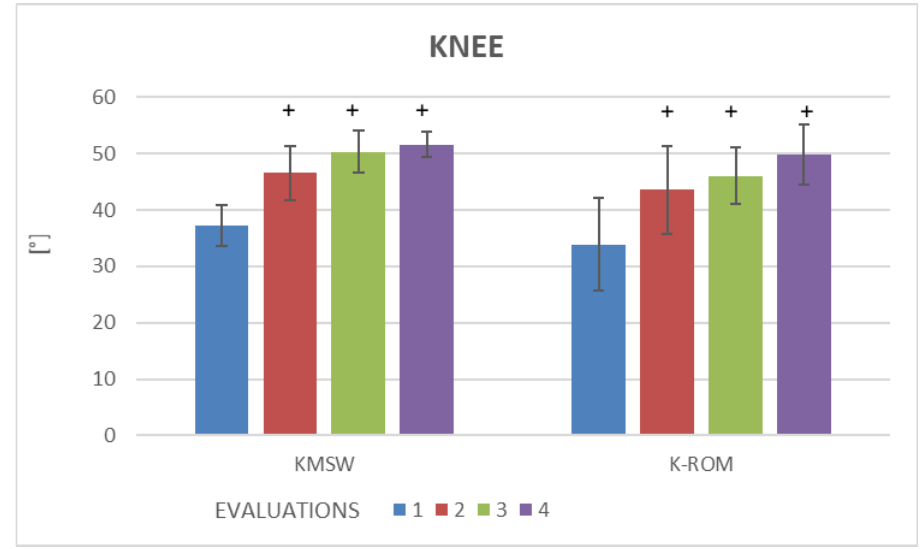
Figure 3. Outcomes of kinematics gait variables, for knee joint of the paretic side, expressed as median values and the interquartile range. + Statistically significant difference in comparison to baseline ( p < 0.05). KMSW = maximum angle of knee flexion in swing; K-ROM = range of motion of knee on the sagittal plane.